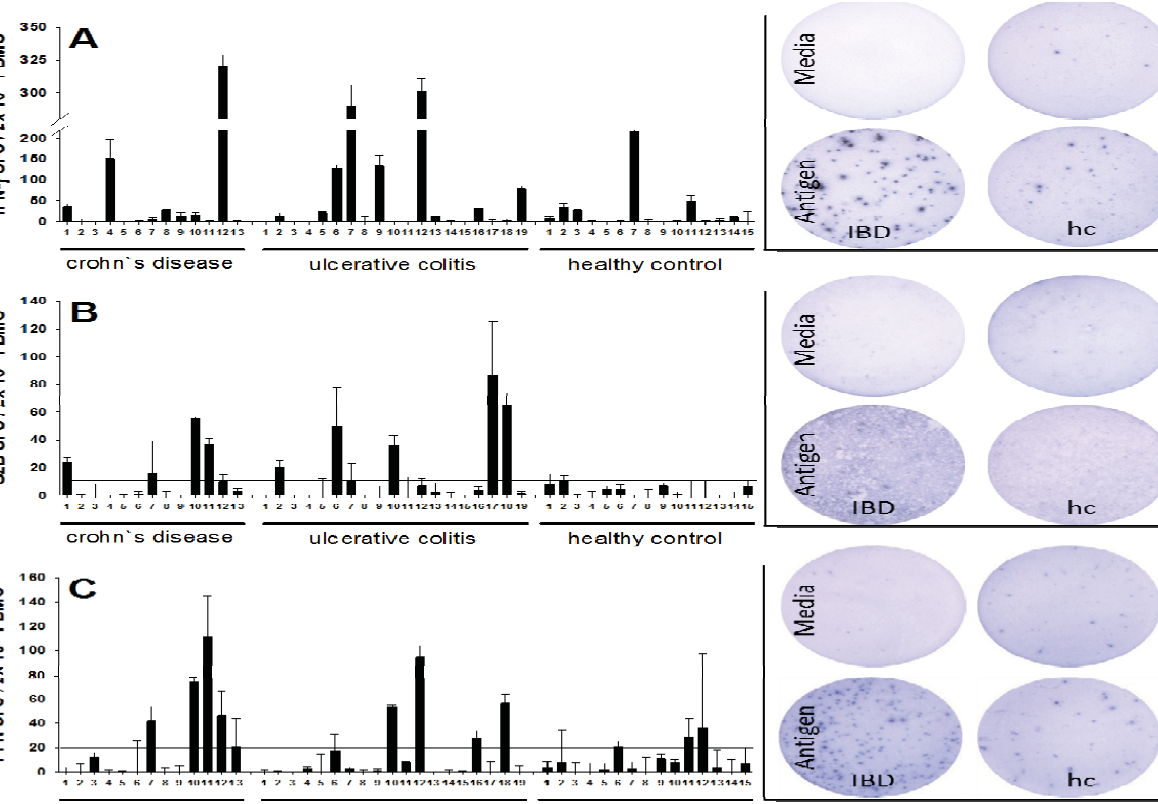
Figure 1. Detection of Cytomegalovirus (CMV)-reactive effector T cells in Inflammatory Bowel Disease (IBD) patients and healthy controls. Peripheral blood mononuclear cells (PBMC) from 32 patients with IBD (ulcerative colitis (UC) or Crohn’s disease (CD)) and a CMV peptide pool containing 5 immunodominant peptides of CMV for 24 h, and